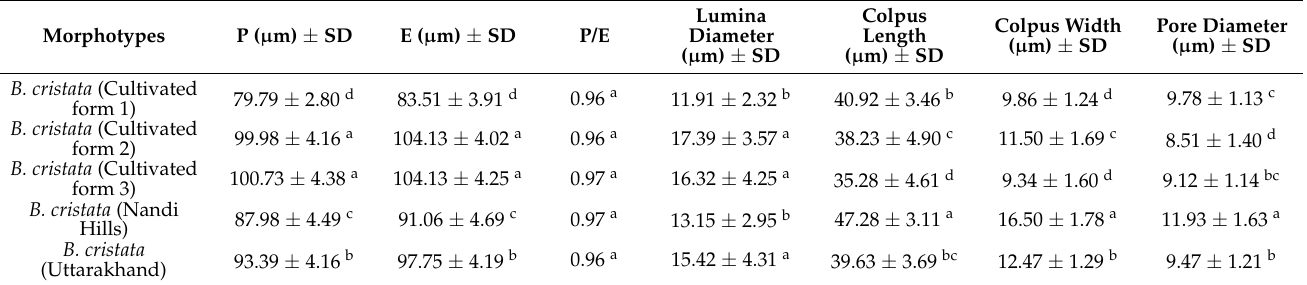
Table 3. Pollen grain features of Barleria cristata morphotypes. E = Equatorial length, P = Polar